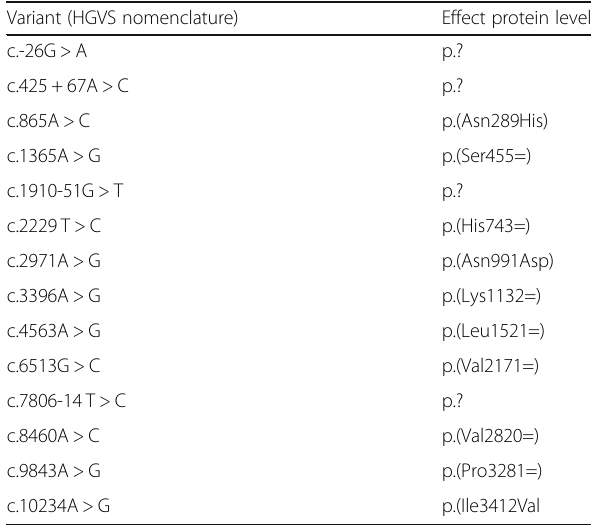
Table 1 BRCA2 variants identified in the index case and classified as benign in ClinVar (RefSeq